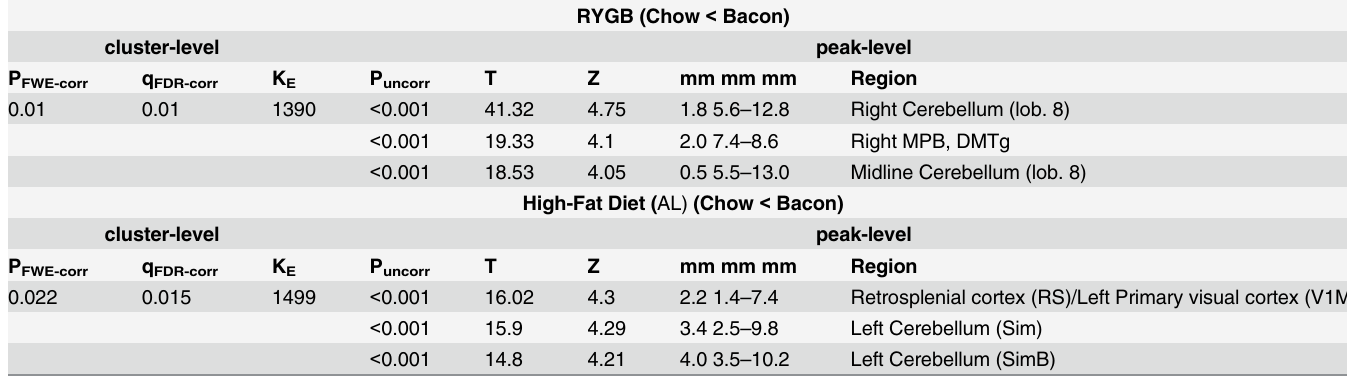
Table 1. SPM Results.